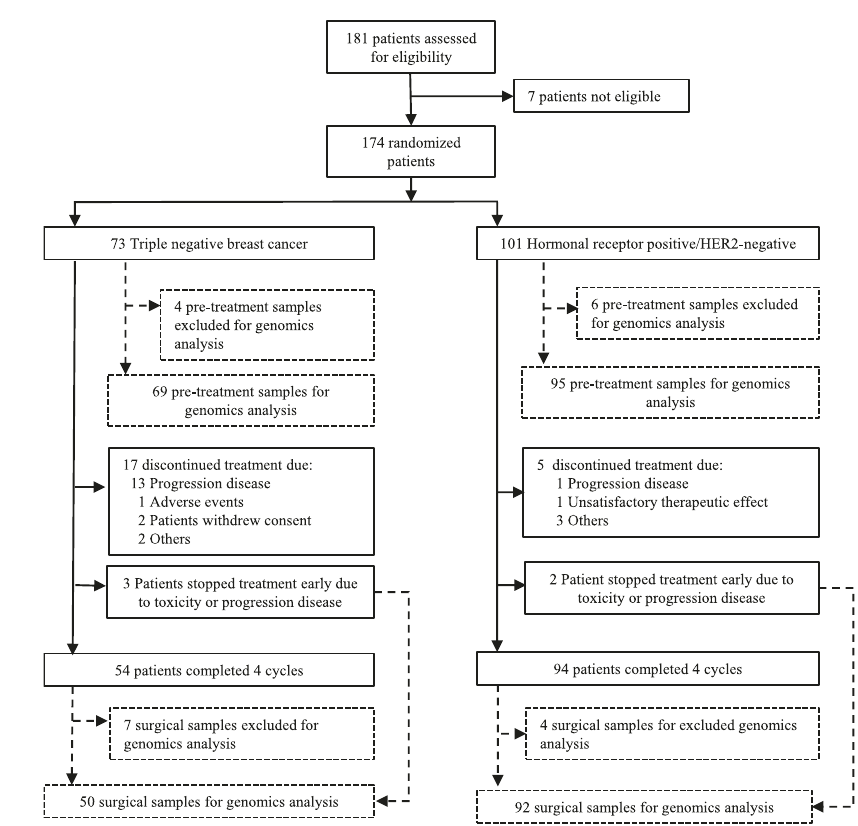
Fig. 2 The CONSORT Flow Diagram. Flow chart of the SOLTI-1007 NeoEribulin